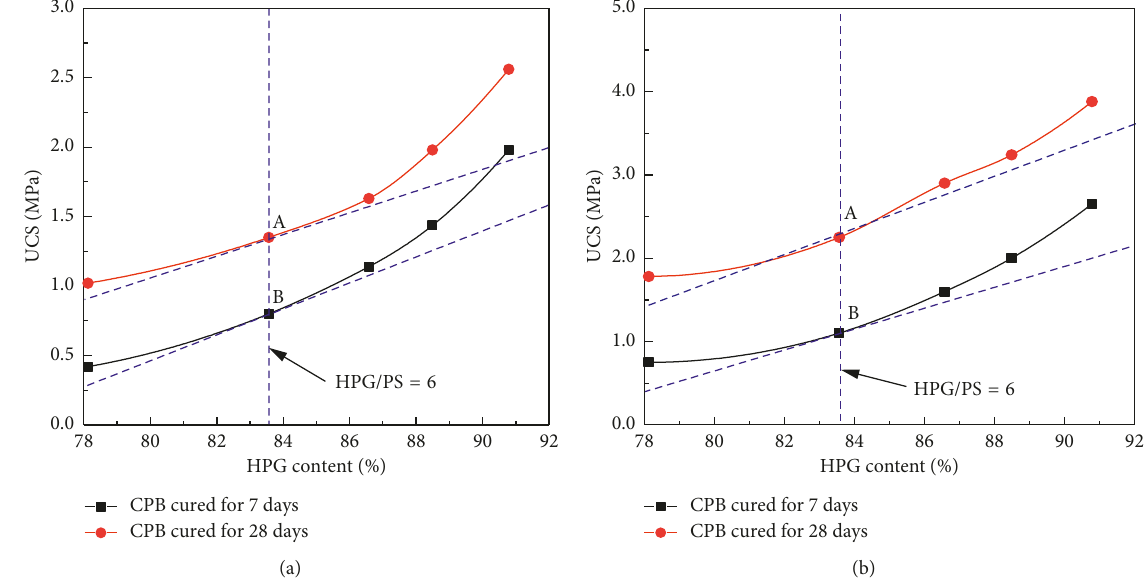
Figure 7: Effect of HPG content on the UCS of backfill body with the addition of 3% quicklime. (a) Mass fraction of 66%; (b) mass fraction of